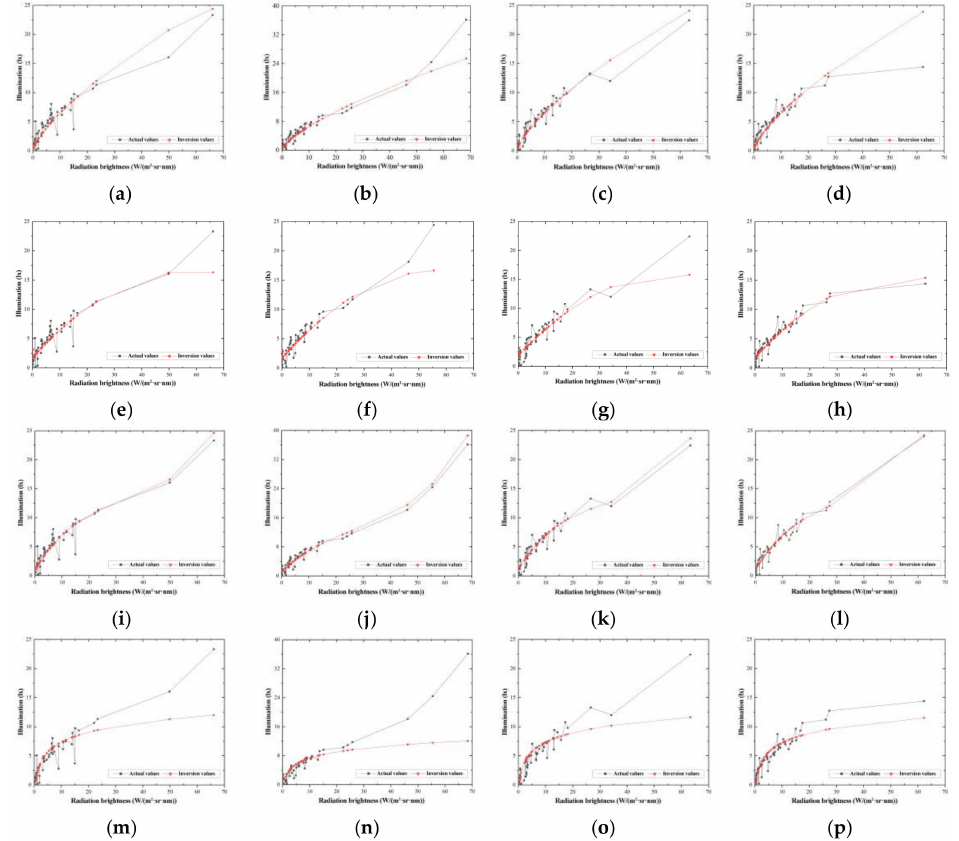
Figure 14. Comparison of actual value and inversion estimation of illuminance of each group. ( a ) Power functions-combination 1; ( b ) Power functions-combination 2; ( c ) Power functions-combination 3; ( d ) Power functions-combination 4; ( e ) Quadratic functions-combination 1; ( f ) Quadratic functions- combinations 2; ( g ) Quadratic function-combination 3; ( h ) Quadratic func-tions- combination 4; ( i ) Cubic functions-combination 1; ( j ) Cubic functions-combination 2; ( k ) Cubic functions-combination 3; ( l ) Cubic functions-combination 4; ( m ) Log functions-combination 1; ( n ) Log functions-combination 2; ( o ) Log functions-combination 3; ( p ) Log functions-combination